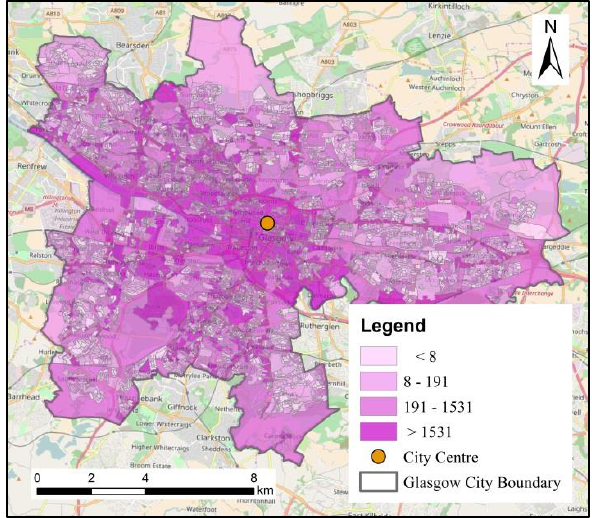
Figure 4. Number of cycling activities in census output